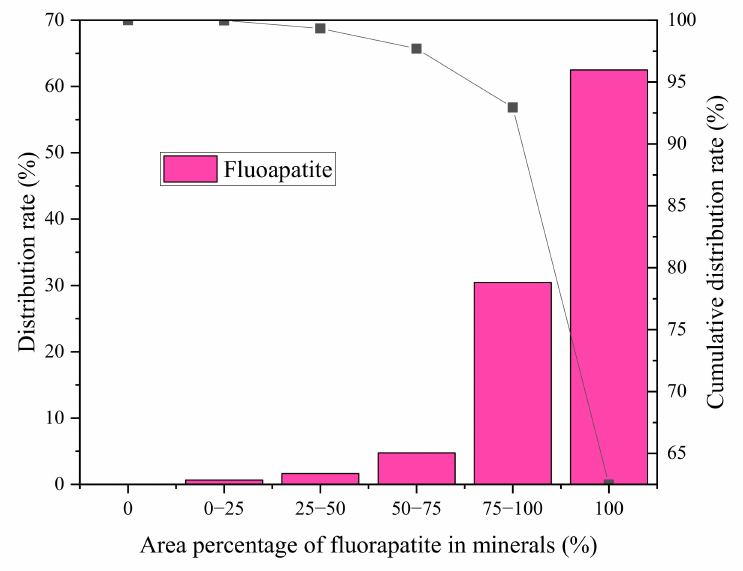
Figure 7. Mono-mineral liberation of fluorapatite: particle size of 0.52–212 µ